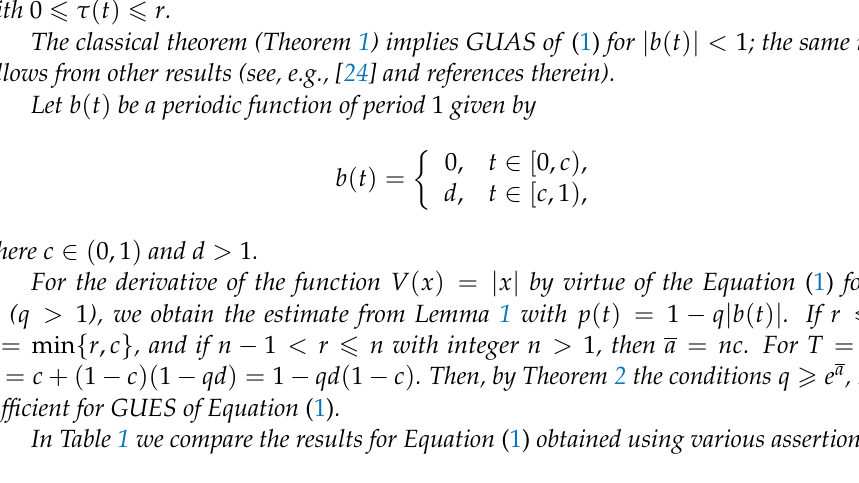
Table 1. Comparison of some sufficient conditions for GUAS (GUES) of Equation